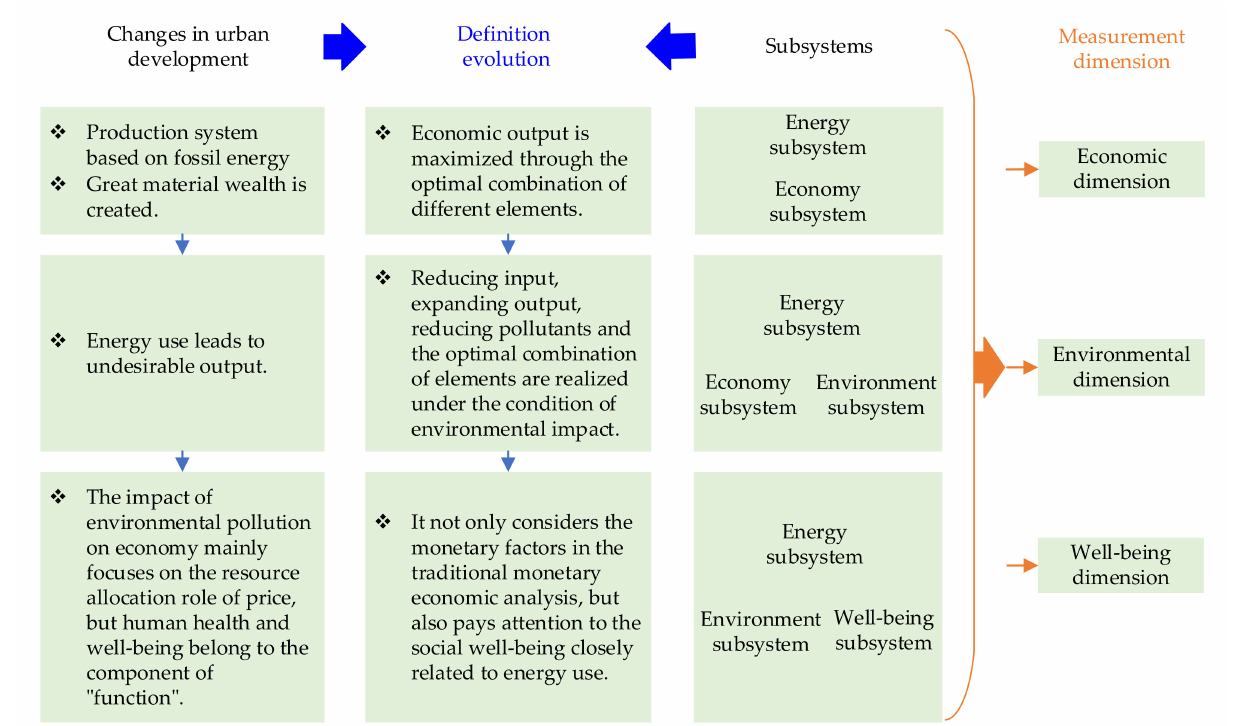
Figure 2. Concept evolution and dimension of urban energy